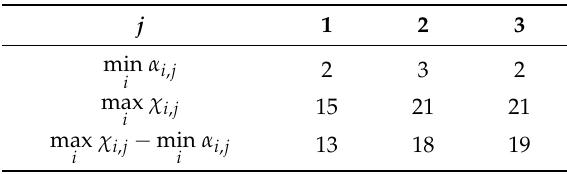
α i , j and max χ i , j for each criterion. i i